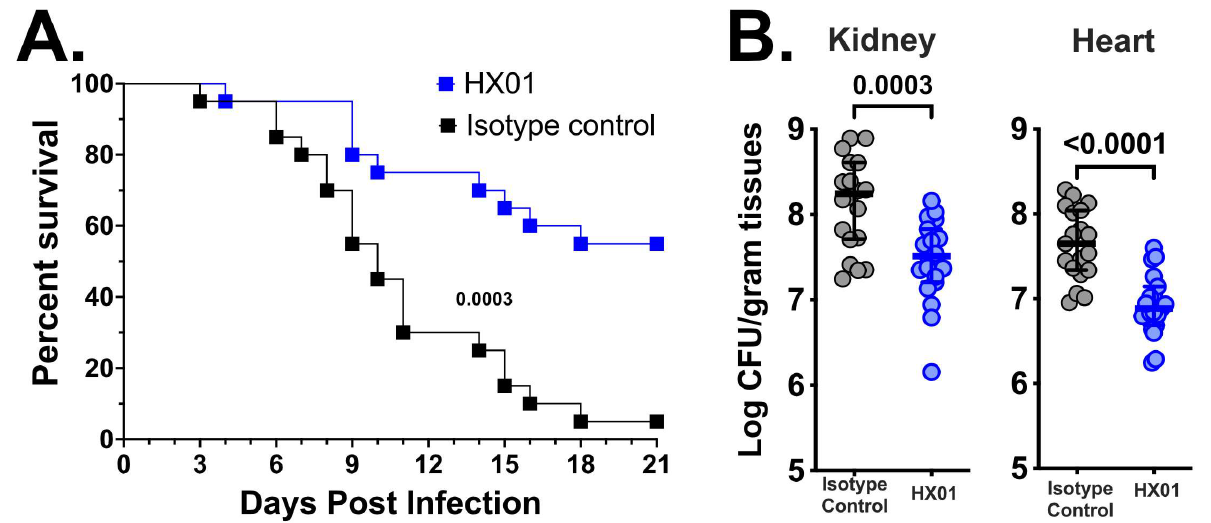
Figure 5. HX01 MAb protects mice from C. auris infection. CD-1 mice ( n = 20/group) were immuno- suppressed with cyclophosphamide and cortisone acetate. Two days after the immunosuppression, mice were infected intravenously with C. auris CAU-09 (5 × 10 7 cells). After 24 h of infection, mice were randomized and divided into two treatment groups of 30 µg/mouse of either HX01 MAb or an isotype-matched control IgG1 (i.p.). Mice survival (compared by Log-rank Test) ( A ) or tissue fungal burden (determined by quantitative culturing on day +4, relative to infection, and analyzed by the Mann–Whitney Test) of the kidney and heart ( B ) were evaluated in separate experiments. Data in ( A , B ) were combined from two independent experiments. p values < 0.05 were considered statistically significant.